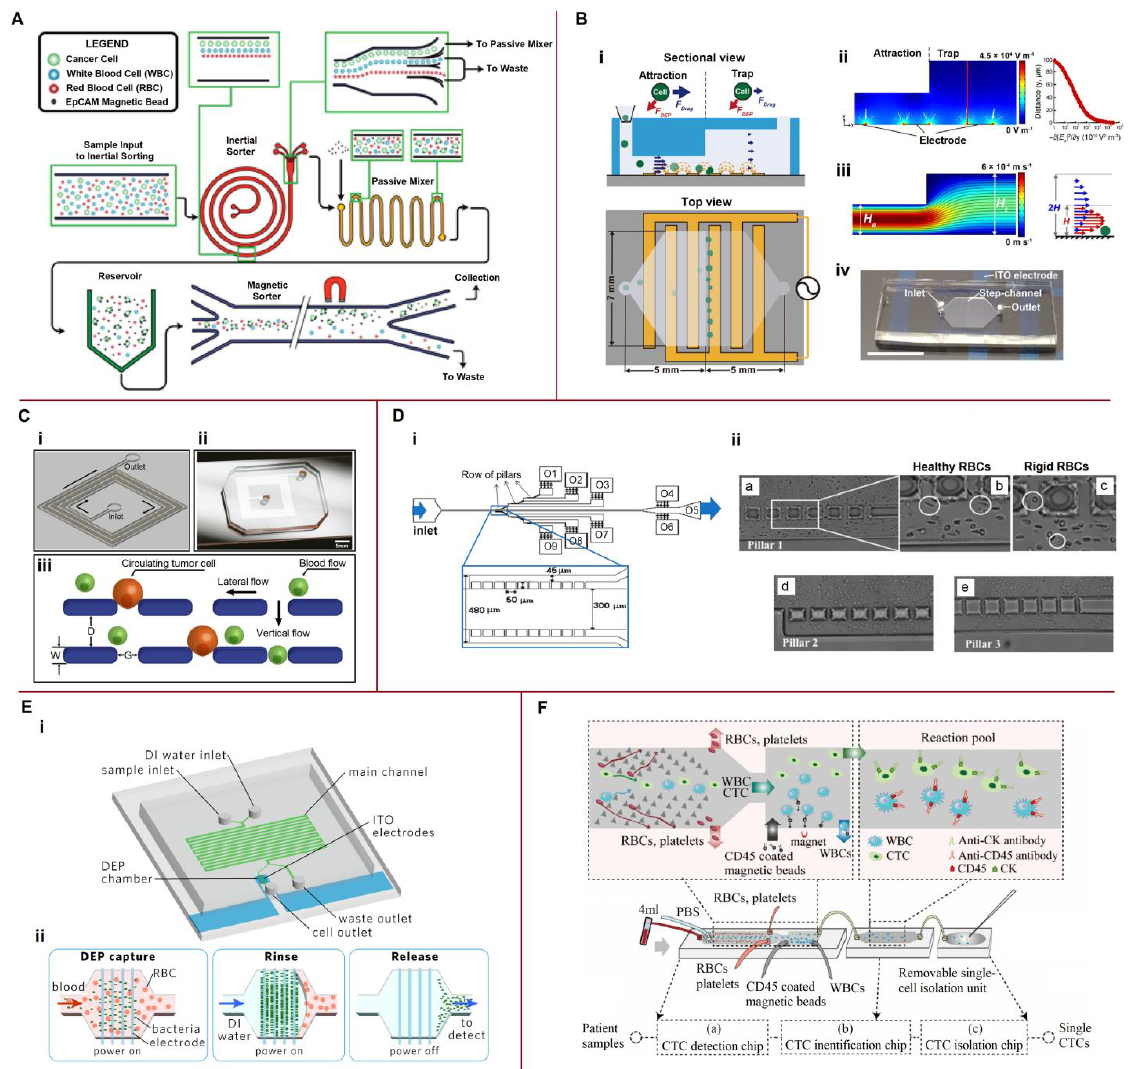
Figure 4. Microfluidic platforms combining hydrophoresis with other techniques. ( A ) Schematic of ultra-specific CTC isolation platform showing inertial sorting, passive mixing with incubation, and magnetic sorting. Reproduced with permission from [110]. Copyright 2016, the authors. ( B ) Design of the step channel and the fabricated device: ( i ) Schematic of the device. ( ii ) Numerical simulation of the electric field. ( iii ) Simulated contours of the flow velocity and streamlines. ( iv ) The fabricated device. The scale bar is 10 mm. Reproduced with permission from [111]. Copyright 2017, the author(s). ( C ) The microfluidic lateral flow filtration ( µ -LaFF) chip: ( i ) design and ( ii ) photographic image of the µ -LaFF chip. ( iii ) Lateral and vertical fluidic flows in microchannel and filtration of CTCs. Repro- duced with permission from [112]. Copyright 2014 Elsevier B.V. ( D ) Microchannel with geometric pillar variations for cell separation and deformability measurements: ( i ) Microchannel geometry with nine outlets (O1–O9). ( ii ) Visualization of cell deformability. Reproduced with permission from [113]. Copyright 2018, the authors. ( E ) Microfluidic device for desalination and enrichment of bacterial cells: ( i ) Diagram of H-filter and positive dielectrophoresis. ( ii ) pDEP capture, rinse